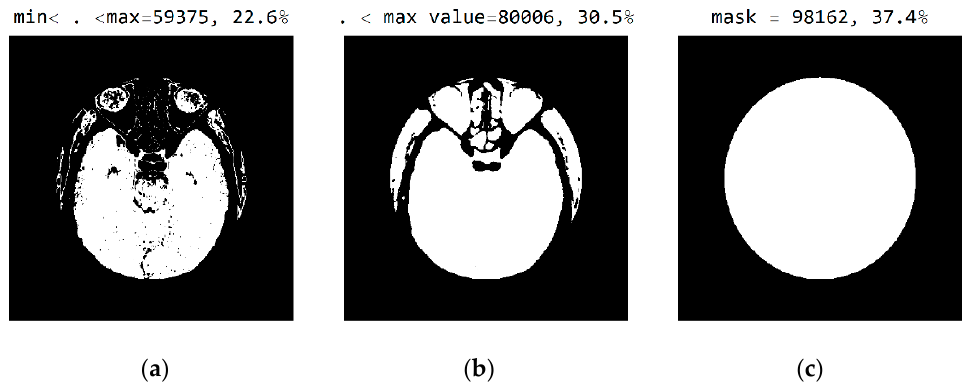
Figure 8 . White represents pixels that will display the correct values: ( a ) in the range from mini- mum to the maximum selected value; ( b ) in the range of values from 1 to 55; and ( c ) in the central part of the image for the selected